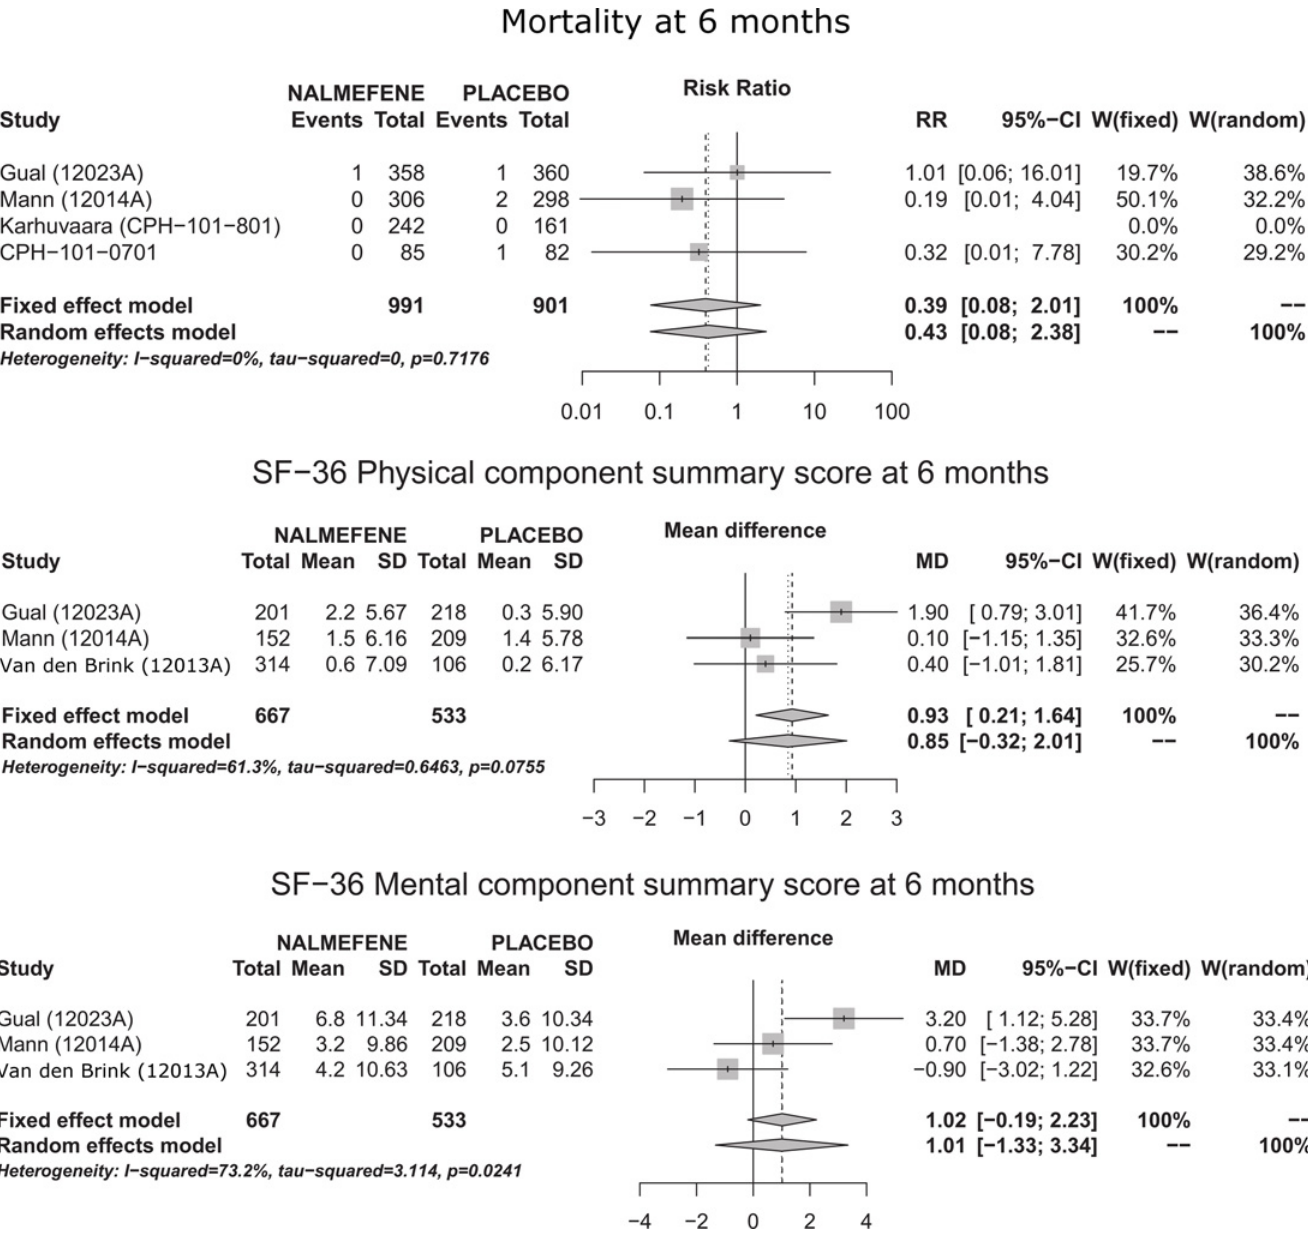
Fig 2. Forest plots for health outcomes at 6